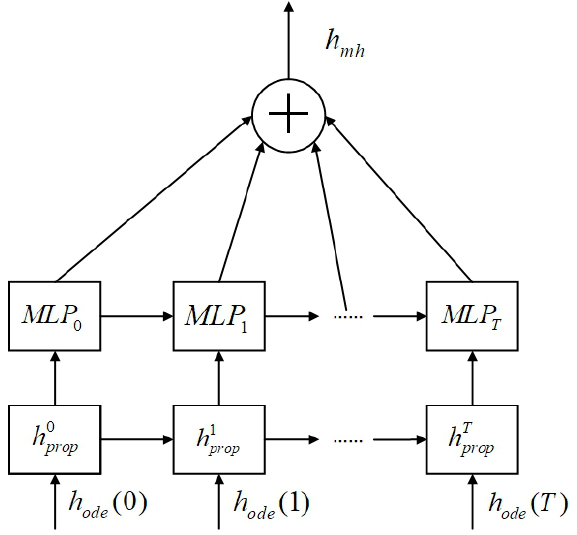
Figure 5. Mix hop